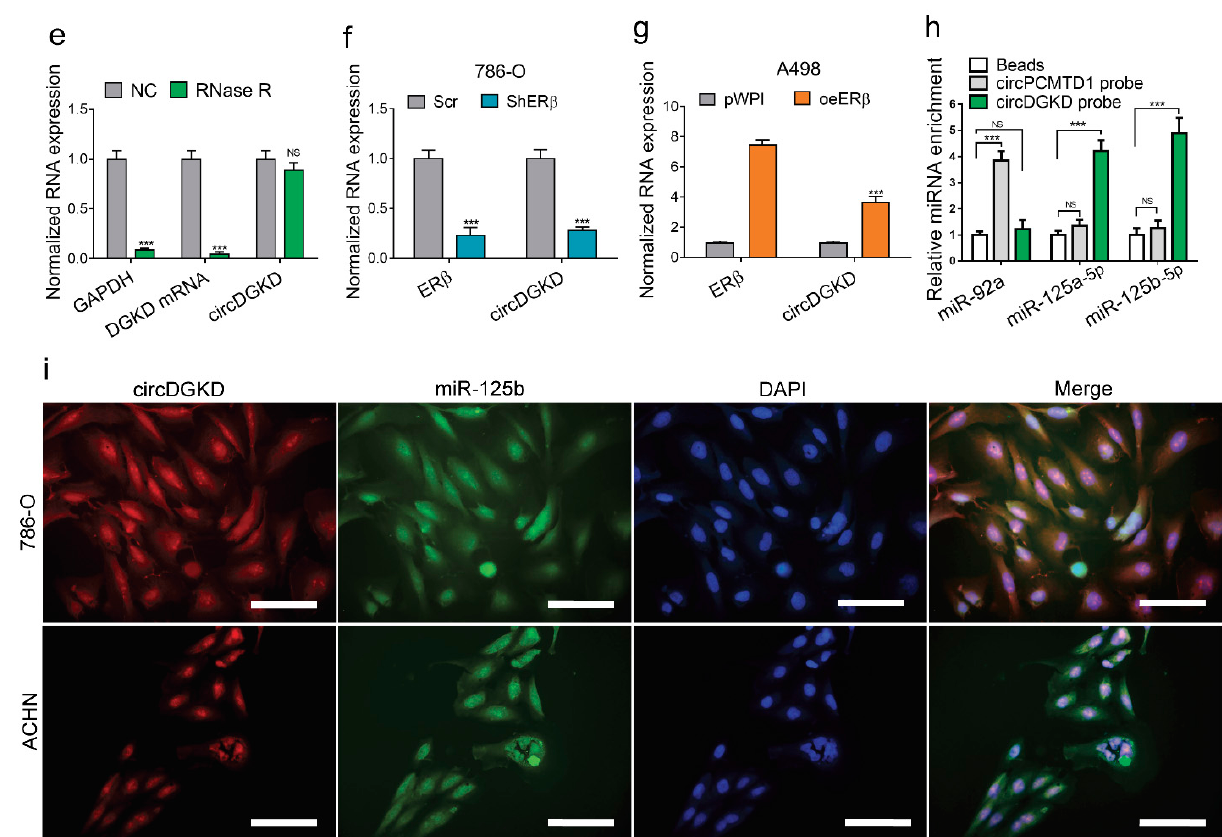
Figure 3. ER β increases circDGKD that sponges miRNA-125-5p in RCC. ( a ) RNASeq analysis of the gene expression of the top 10 potential circRNA candidates that might sponge miR-125-5p. ( b ) Detailed information about circDGKD retrieved from Circbase. ( c ) Binding site information of miR-125-5p with the circDGKD from Starbase. ( d ) Schematic diagram demonstrating the structure of circDGKD and qPCR primers for circDGKD. ( e ) QPCR confirmation of circDGKD after RNase R digestion. ( f ) Knockdown of ER β -reduced circDGKD in 786-O cells. ( g ) Overexpression of ER β - increased circDGKD in A498 cells. ( h ) RNA pull-down assay using biotinylated probe specifically targeting junction region showed that miR-125a-5p and miR-125b-5p were highly specifically enriched in circDGKD, but not in circPCMTD1 (negative control) anti-sense probe pull-down product. The binding of miR-92a to circPCMTD1 was applied as control. ( i ) Fluorescence in situ hybridization (FISH) assay using probe targeting circDGKD tagged with Cy3 (red) and exogenous miR-125b-5p tagged with FAM (green) showed co-localization of circDGKD and miR-125b-5p in 786-O (upper row) and ACHN (lower row) cells. Scale bar, 10 µ m. Data are presented as mean ± SEM. *** p <